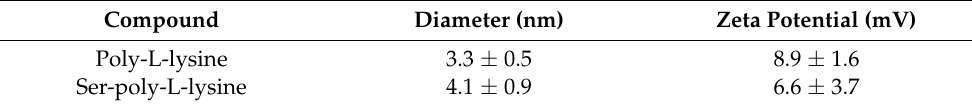
Table 1. Physicochemical properties of poly-L-lysine and Ser-poly-L-lysine.